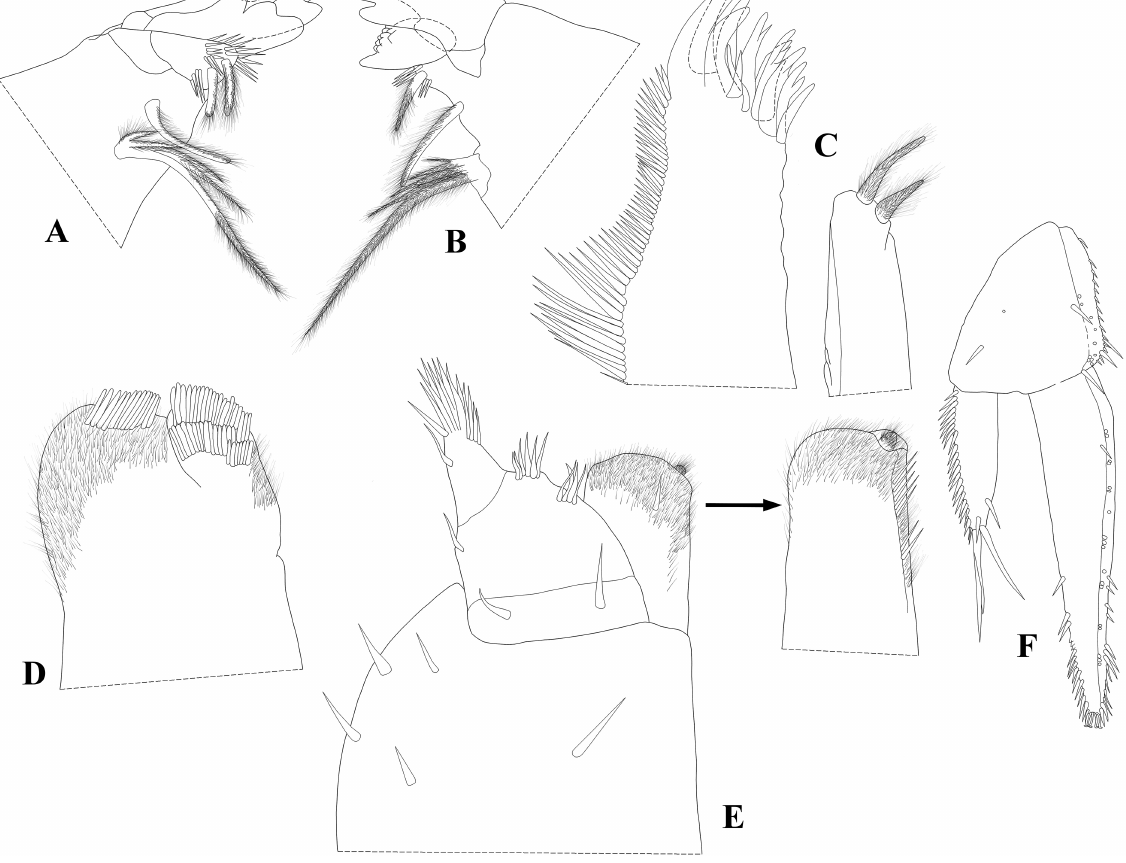
Fig. 16. Halophiloscia trichoniscoides (Vandel, 1973) comb. nov., ♀ (MZUF 9607). A . Left